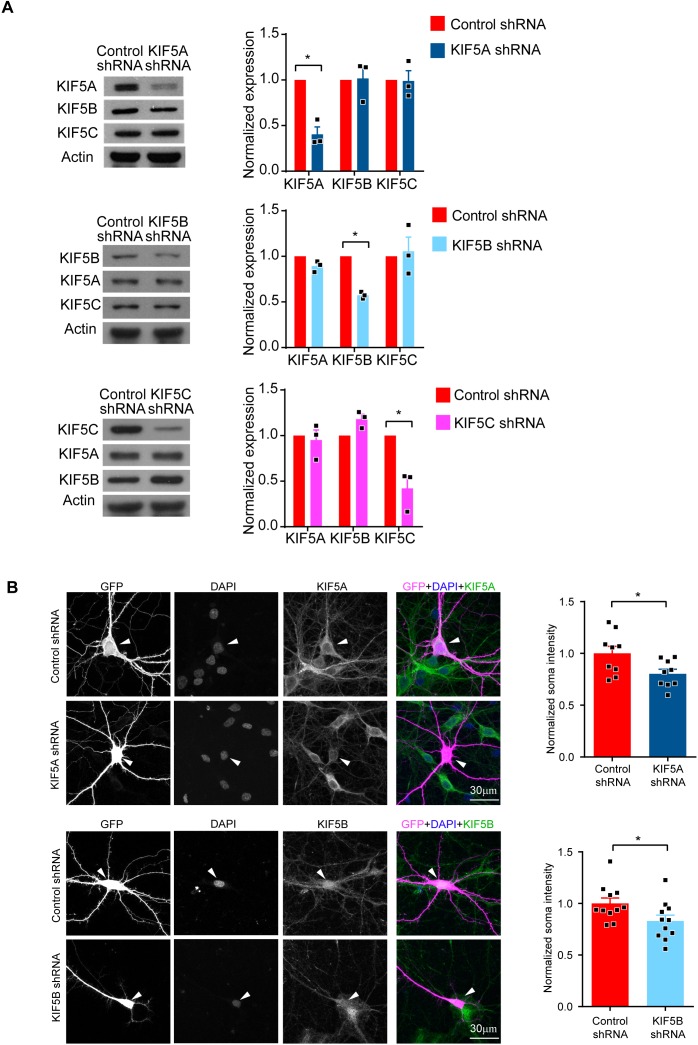
Validation of the knockdown efficiency and specificity of different shRNAs targeting KIF5.(A) For western blot analysis, cortical neurons were transfected with the different shRNAs by nucleofection. At DIV 5, lysate was collected for Western blotting with antibody that specifically recognized each KIF5 homolog (three independent experiments; mean + SEM; multiple t-test with the Holm-Sidak method, alpha: 0.05). (B) For immunofluorescent staining analysis, different shRNAs were transfected into hippocampal neurons at DIV 11 for 6 days and the soma intensity for the corresponding KIF5 homolog was analyzed. 9 or 11 neurons of each group were quantified. Data are presented in mean + SEM; *p<0.05; Student’s t-test.
Figure 1—figure supplement 1—source data 1.Plotted values for Figure 1—figure supplement 1.